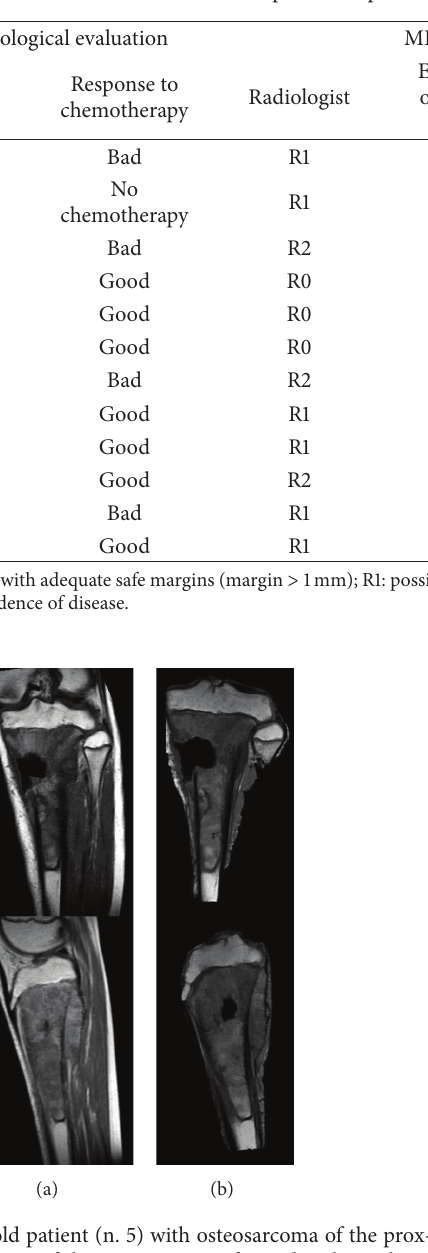
Table 2: Comparison of pathological evaluation and MRI evaluation.